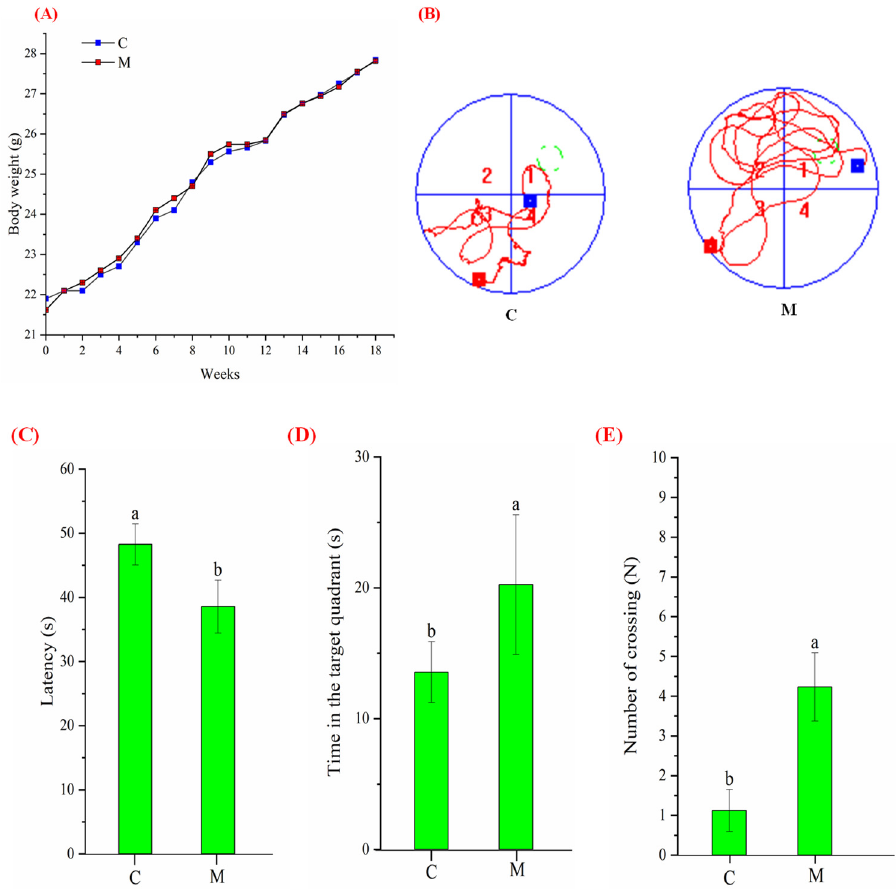
Figure 1. The effects of body weight, learning, and memory capacity after 18 weeks of MFGM intervention in mice: ( A ) changes in body weight of mice with feeding time; ( B ) schematic diagram of mice movement trajectory in the space exploration experiment. The red square represents the point where the mouse entered the water, the blue square represents the point where the mouse was located after the 60 s timing, and the green circle dotted line represents the original platform placement point; ( C ) analysis of the exploration time; ( D ) analysis of time in the target quadrant; and ( E ) analysis of the number of times crossing. All experiments were in triplicate. Different lowercase letters (a, b) in ( C – E ) means significant statistical differences. Capital letters “C” and “M” in ( A , B ) represent control and experimental groups, respectively. Data are presented as mean ± SEM, p < 0.05 compared to the control group.